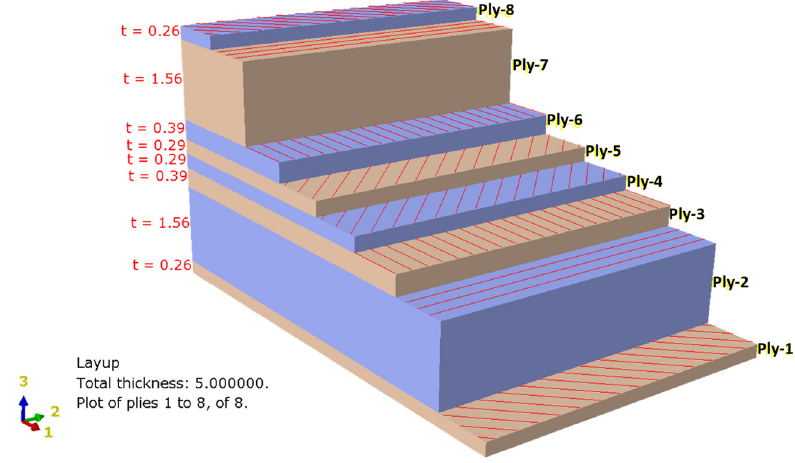
Figure 16. Illustration of the stratification of the blade on Abaqus.